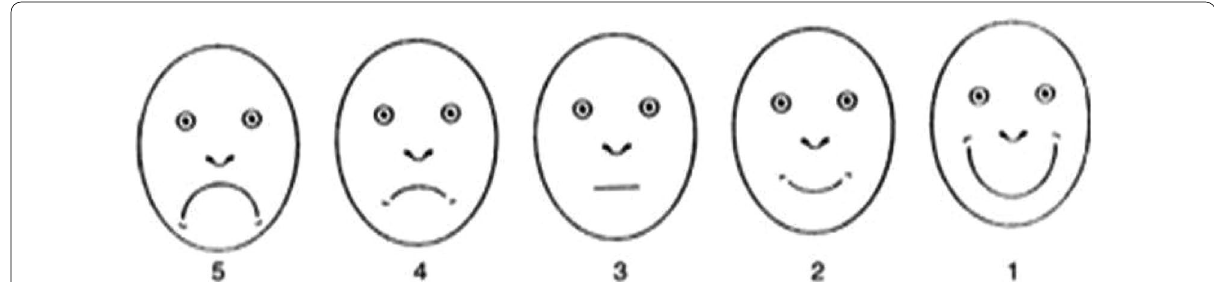
Fig. 6 Facial Image Scale Scorecard (Giri et al. 2017)